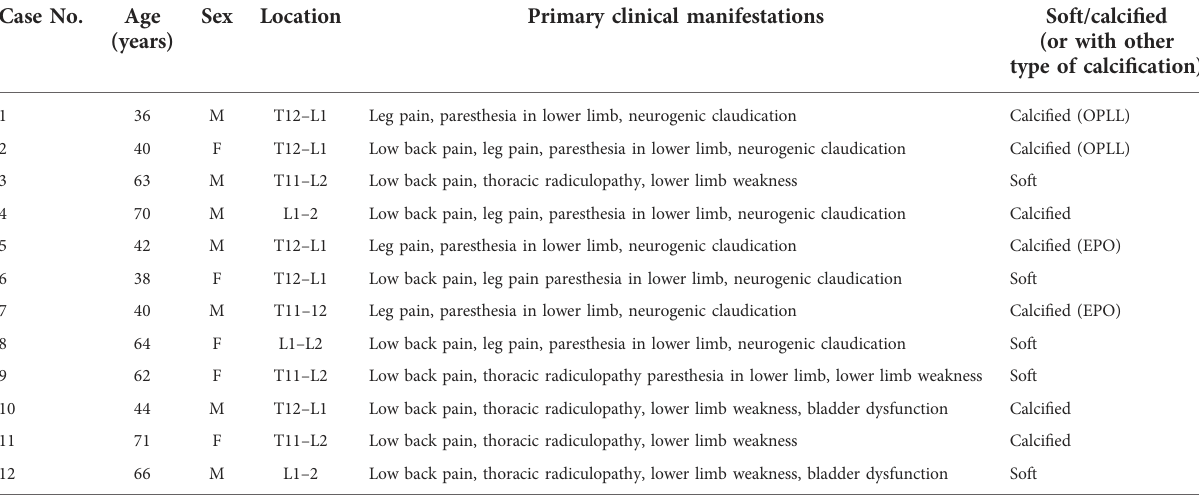
TABLE 2 Summary of preoperative primary clinical manifestations and imaging features of the 12 patients who were treated with fully endoscopic transforaminal discectomy and ventral decompression surgery. Case No.